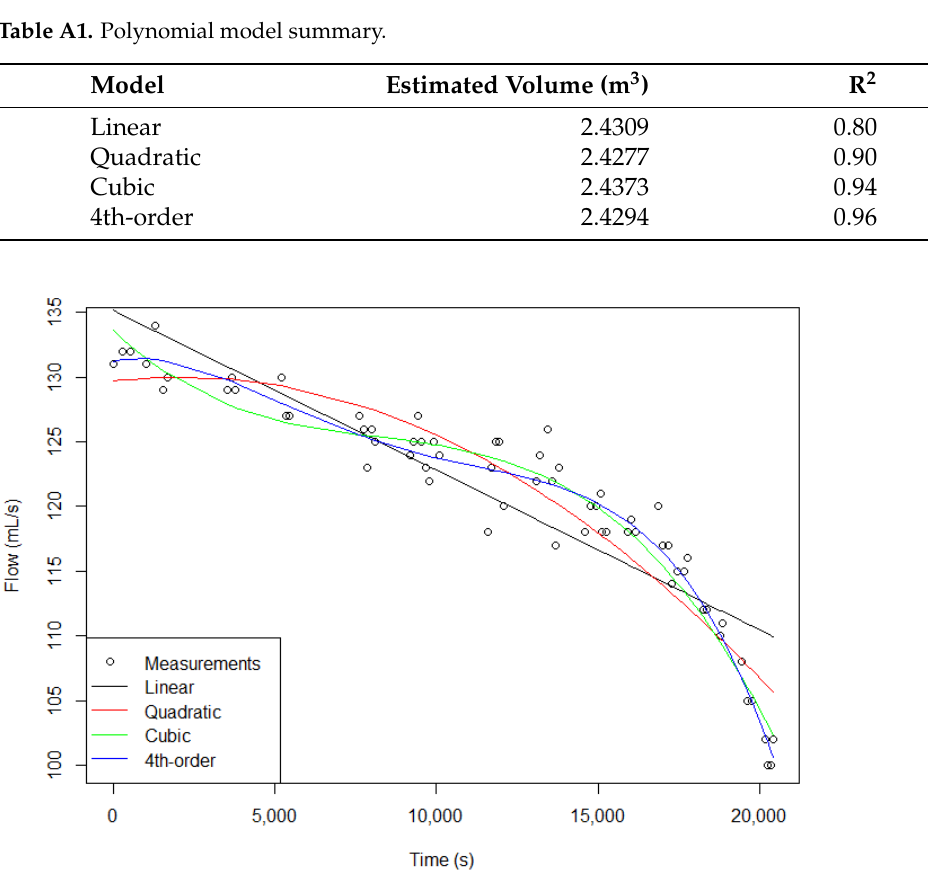
Figure A2. Polynomial models predicting the rate at which the flume